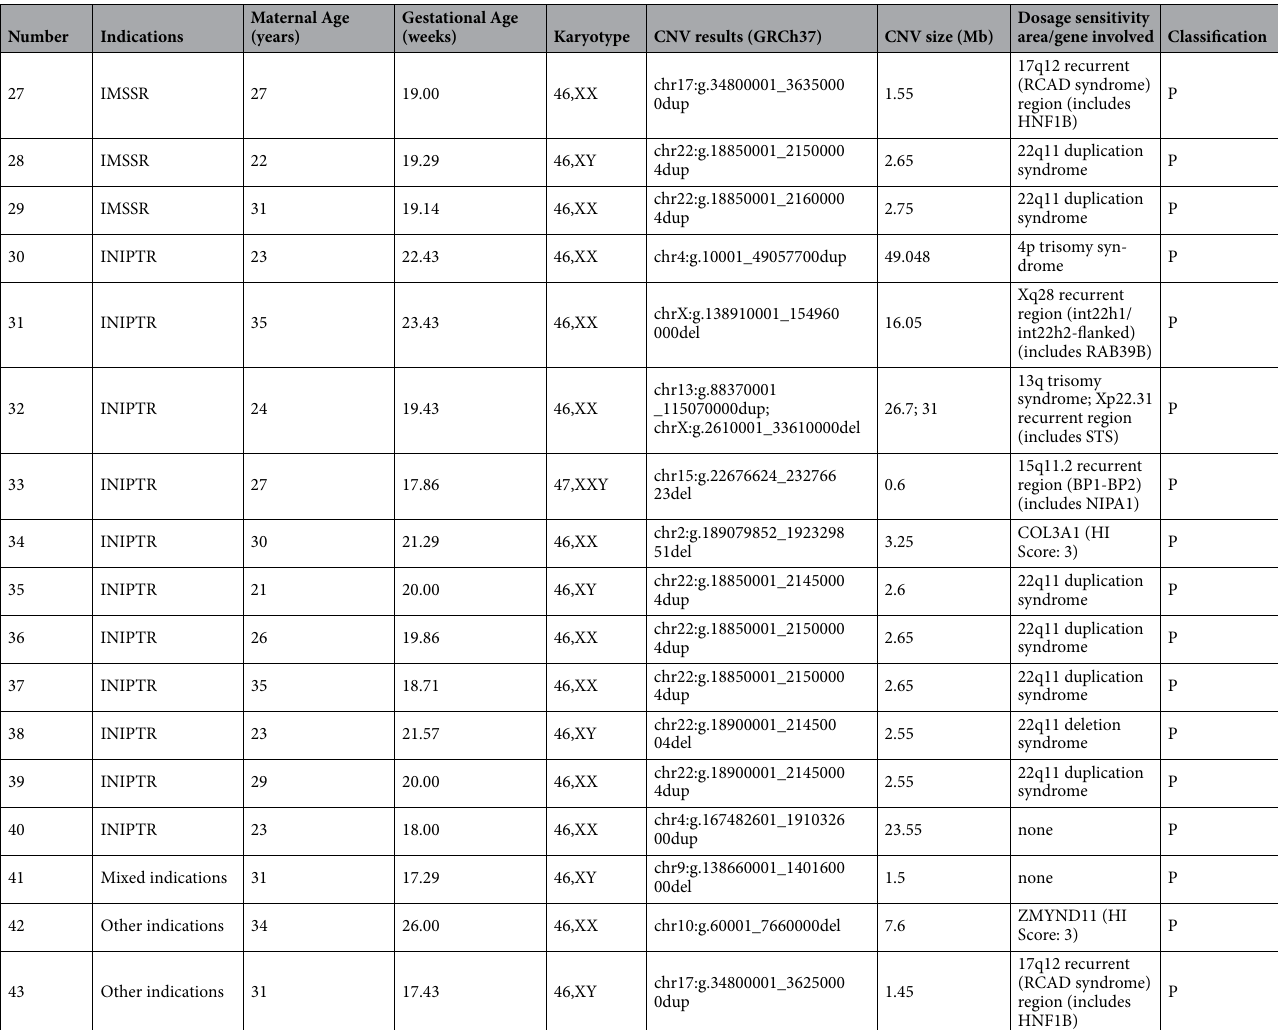
Table 6. Detailed information of pCNS and lpCNVs in the karyotyping and QF-PCR group. UA, ultrasound abnormalities; AMA, advanced maternal age; IMSSR, increased maternal serum screening risk; INIPTR, increased risk of NIPT; P, pathogenic; lp, likely pathogenic CNVs. Other indications included previous fetus/ child with genetic or phenotypic abnormalities, carriers of monogenic genetic diseases, medication during pregnancy, embryos stop developing, intellectual disability of pregnant